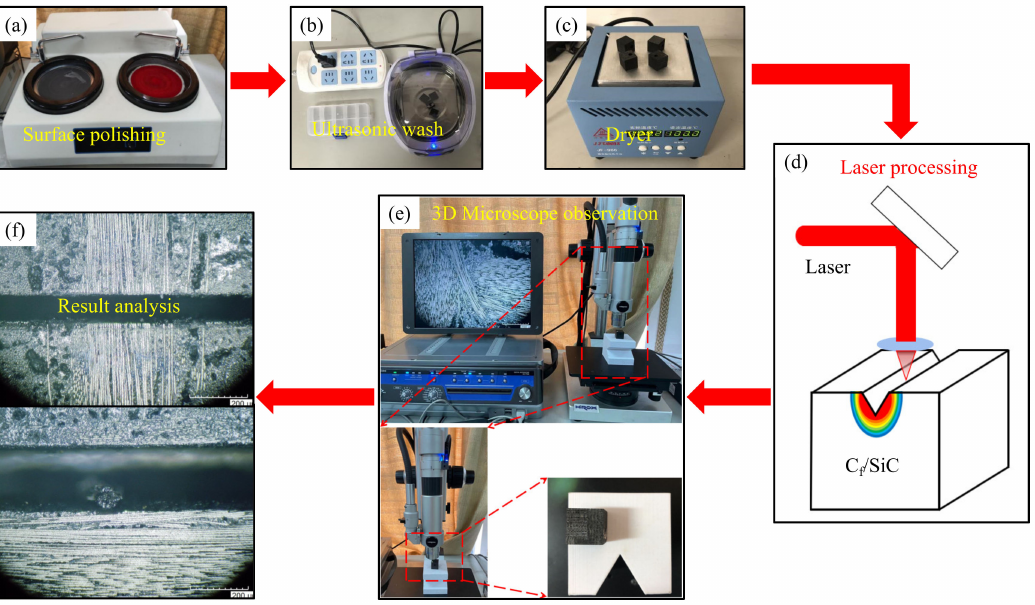
Figure 2. Experimental flow chart (( a ). surface polishing; ( b ). ultrasonic wash; ( c ). dryer; ( d ). laser processing; ( e ). 3D microscope observation; ( f ). result